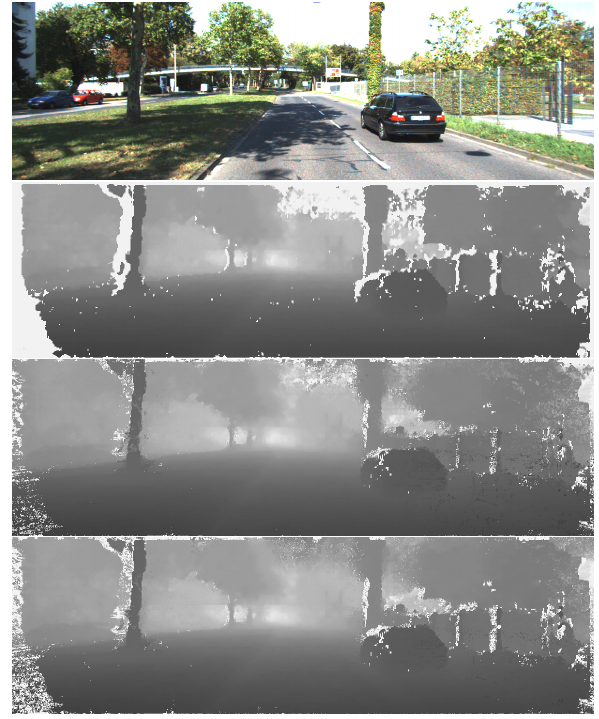
Figure 7. Results on a frame of sequence 2011_09_26_drive_0013 of the KITTI raw data recordings. See fig. 3 for parameter description. Note the moving